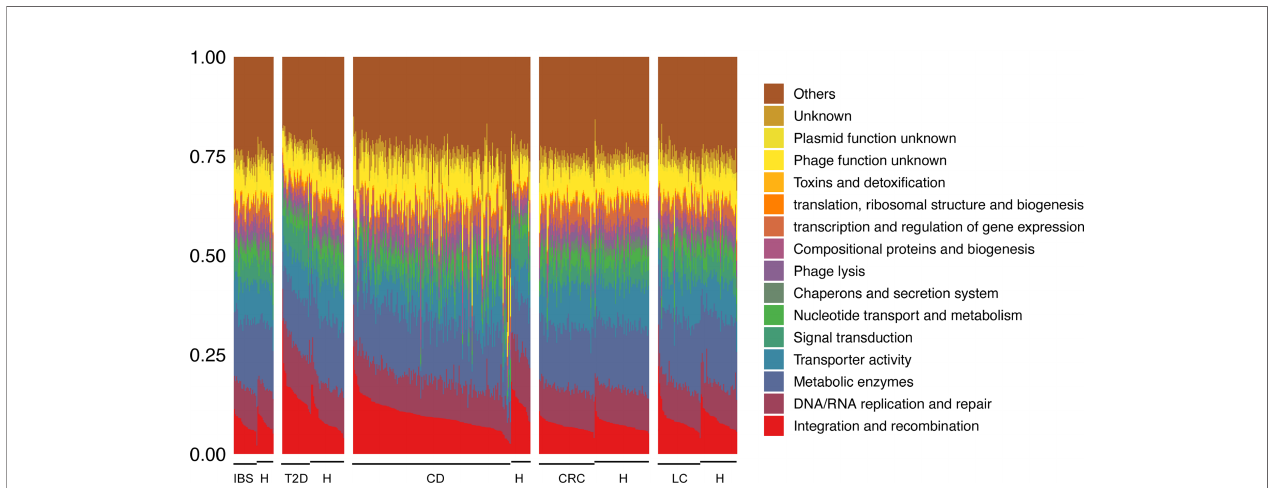
FIGURE 6 | Composition of 16 categories of viral gene functions based on the VirGenFunD functional annotations. Samples from the same data source were grouped, and the label “ H ” stands for healthy controls. Not surprisingly, some conserved backbone functions such as phage integration and transpositional recombination, DNA/ RNA replication, and repair occupied a substantial part of the whole viral functions. Phage lysis, metabolic enzymes, transporter activity, and signal transduction-related function were also active in viral gene functions. At the same time, accessory gene functions such as toxins and detoxi fi cation were also